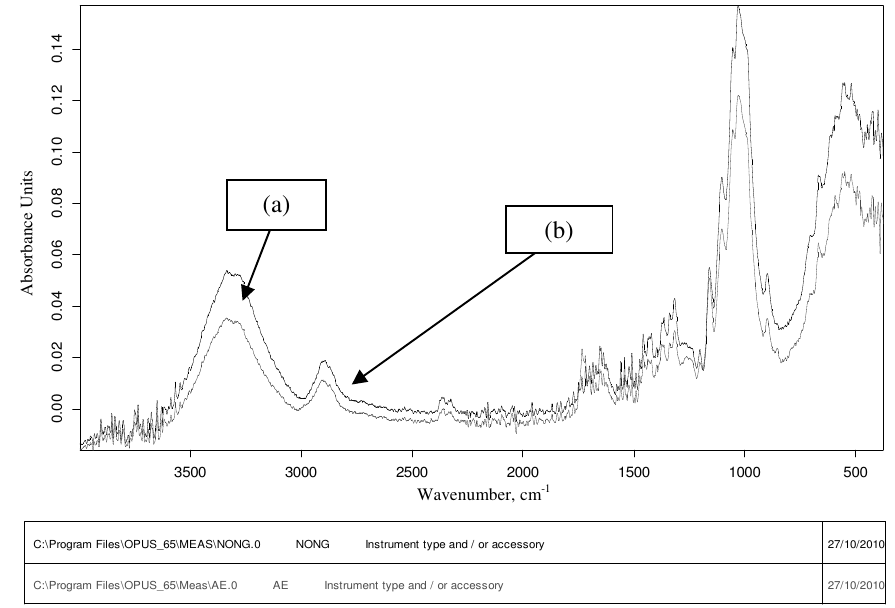
Figure 1. IR spectra of non-grafted fibres (a) and grafted fibres